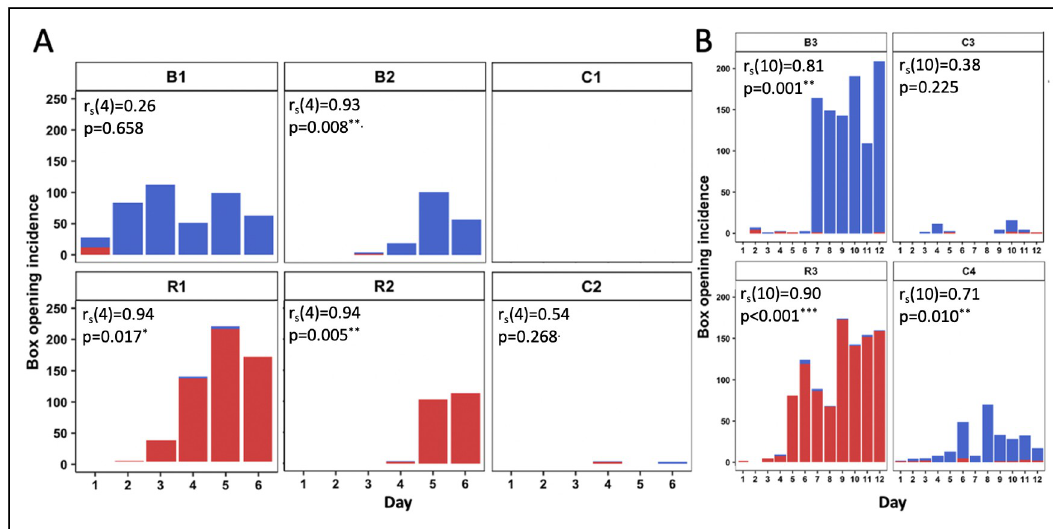
Fig 3. Daily incidence of box openings by observers in (A) Experiment 1 and (B) Experiment 2. Colonies R1, R2, and R3; and B1, B2, and B3 were seeded with single demonstrators trained to perform the red-pushing behavioural variant and the blue-pushing behavioural variant, respectively. Colonies C1, C2, C3, and C4 were controls that lacked a demonstrator. A box opening was assigned to an observer whenever it pushed on either tab � 50% of the required distance and obtained the reward. Incidences of the “blue- pushing behavioural variant” are depicted in blue, while incidences of the “red-pushing behavioural variant” are depicted in red. Data for the whole colonies and demonstrator activity can be found in S1 Fig and S1 Table. Relationships between experimental day and opening incidence (of any variant) by observers were analysed using Spearman’s rank order correlation tests; � p < 0.05, �� p < 0.01, and ��� p < 0.001. The data underlying this figure can be found in https://doi.org/10.6084/m9.figshare.21353973.